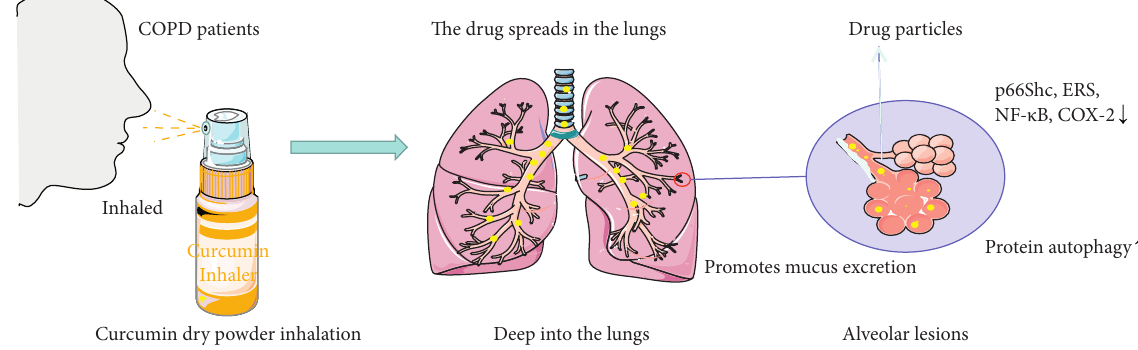
Figure 2: Principles of application and pharmacological effects of dry powder inhalation of